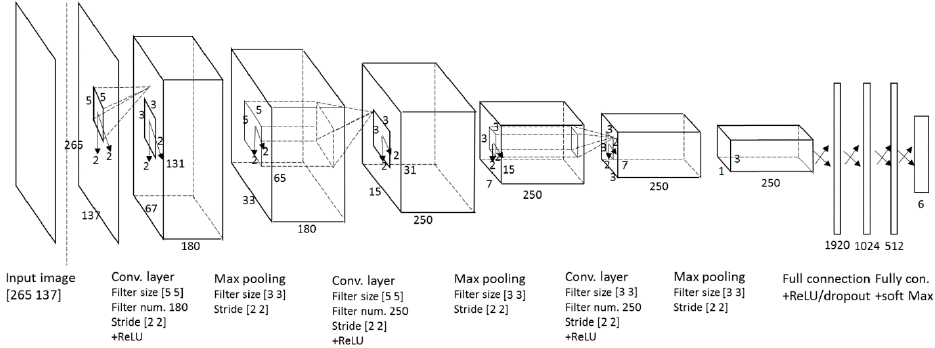
Figure 2. Convolutional neural network (CNN) architecture.